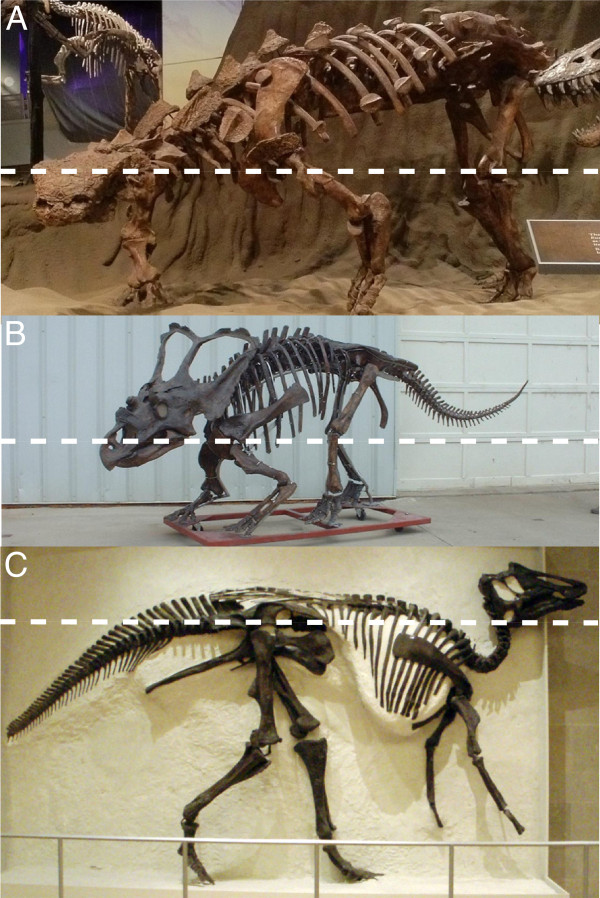
Quadrupedal MFH proxies used in this study. Shoulder height (calculated as the combined lengths of the humerus, radius, and metacarpal III) is used to approximate the MFHs of ankylosaurs (A), ceratopsids (B), and other small, quadrupedal forms. Hip height (calculated as the combined lengths of the femur, tibia/fibula, and metatarsal III) is used to approximate the quadrupedal MFHs of hadrosaurids (C). Dashed lines indicate the approximate quadrupedal MFH. Image (B) provided by G. Danis (used with permission).